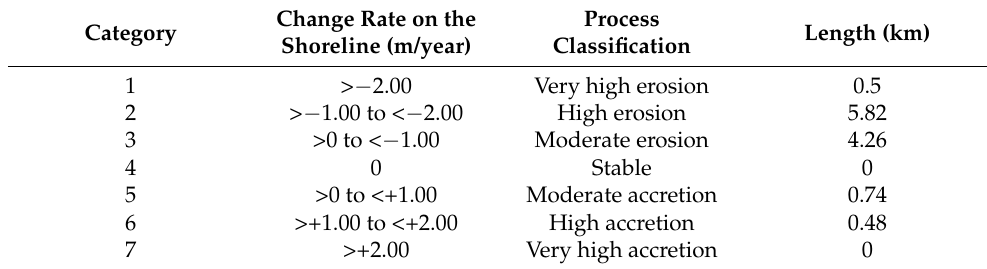
Figure 6. Shorelines extracted for the study years. Table 5. Different classifications for change rates on the